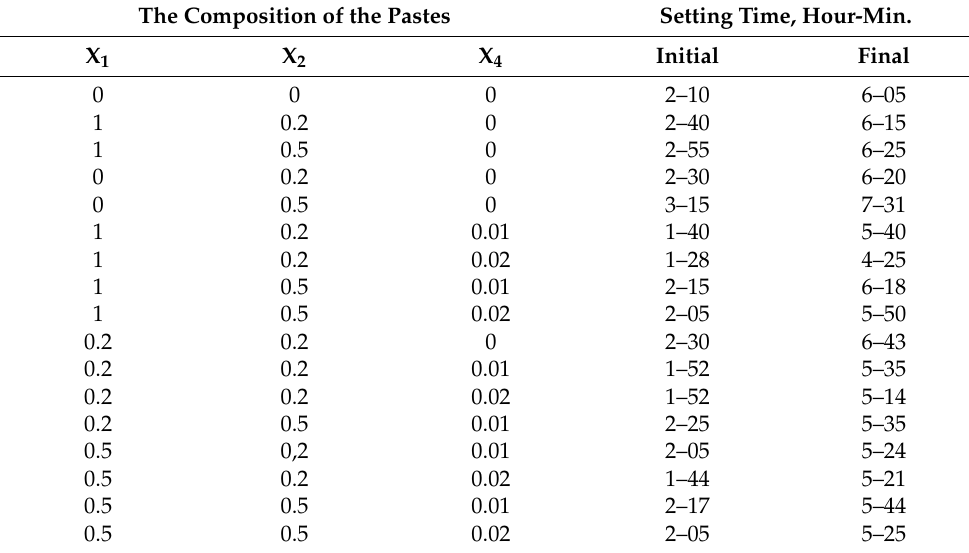
Table 5. Setting time of filled cement-water pastes.